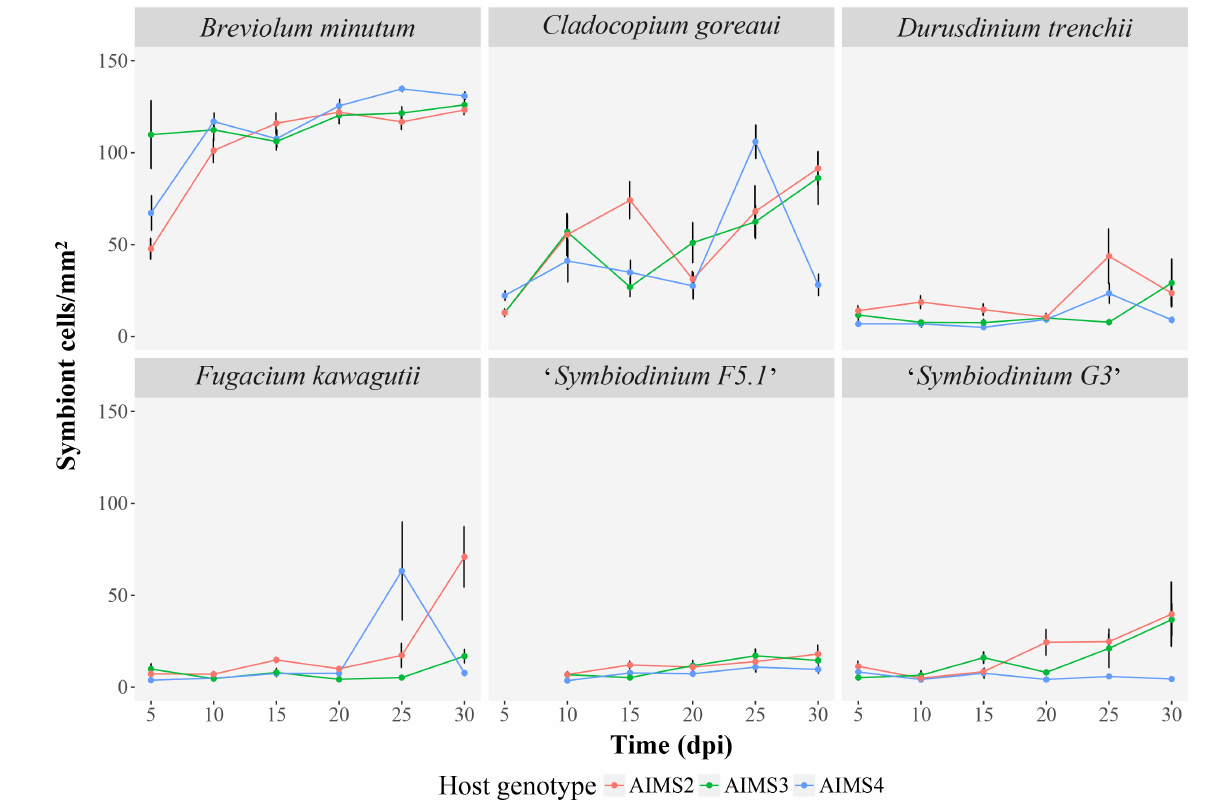
FIGURE 3 | Colonization of three E. diaphana genotypes (AIMS2, AIMS3, AIMS4) with six Symbiodiniaceae ( B. minutum , N = 146; C. goreaui , N = 156; D. trenchii , N = 157; F. kawagutii , N = 138; “ Symbiodinium F5.1”, N = 135; “ Symbiodinium G3”, N = 144) during the 30-days experiment. Each panel of the graph represents the mean ( ± SEM) density of one algal symbiont type in tentacles of three anemones per genotype at each time point post-inoculation (5, 10, 15, 20, 25, 30 dpi). Where error bars are not visible, they are small and hidden by the symbols. Exposure of anemones to Symbiodinium tridacnidorum resulted in the decease of all organism hence it was not possible to sample the tentacles for analysis. For “ Symbiodinium F5.1” it was not possible to perform the sampling at 5